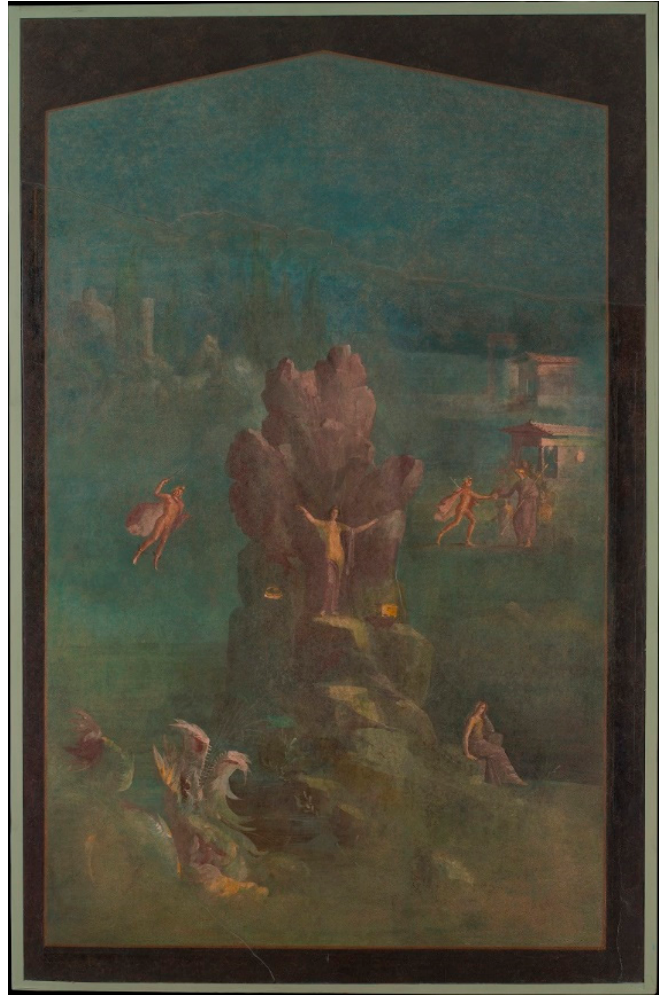
Figure 1. Central mythological picture from cubiculum 19 of the Boscotrecase Villa with Perseus and Andromeda, third style, New York, Metropolitan Museum 20.192.16; © public domain dedication (CC0 1.0) (photograph provided by the Metropolitan Museum of Art).